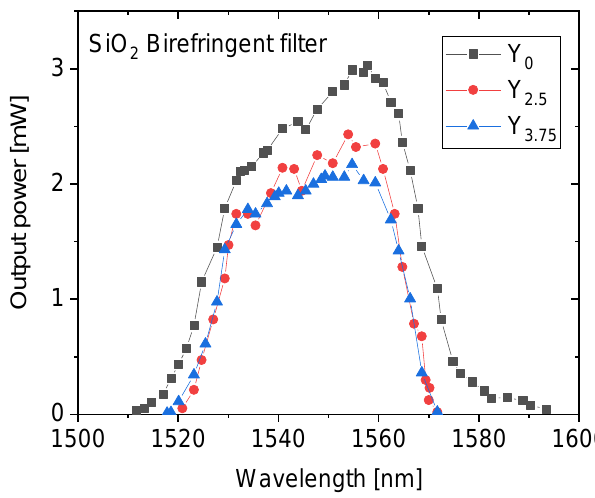
The tuning of wavelength was achieved with all glasses and the measured tuning curves are shown in Figure 11.